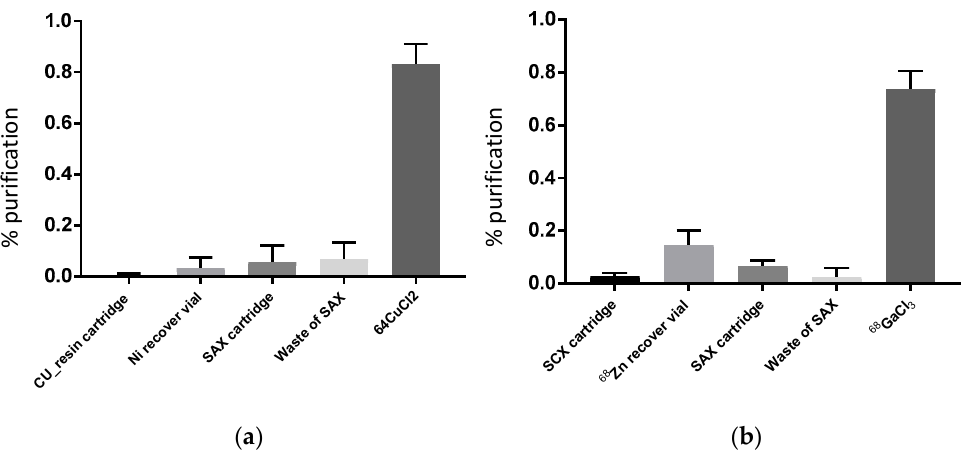
Figure 3. Average yields and activity loss in each step. Purification of 64 CuCl 2 ( a ), with 81.2 ± 7.8% (decay corrected) yield in 1 h of process. Purification of 68 GaCl 3 ( b ), with 73.9 ± 6.7% (decay corrected) yield in 35 min of